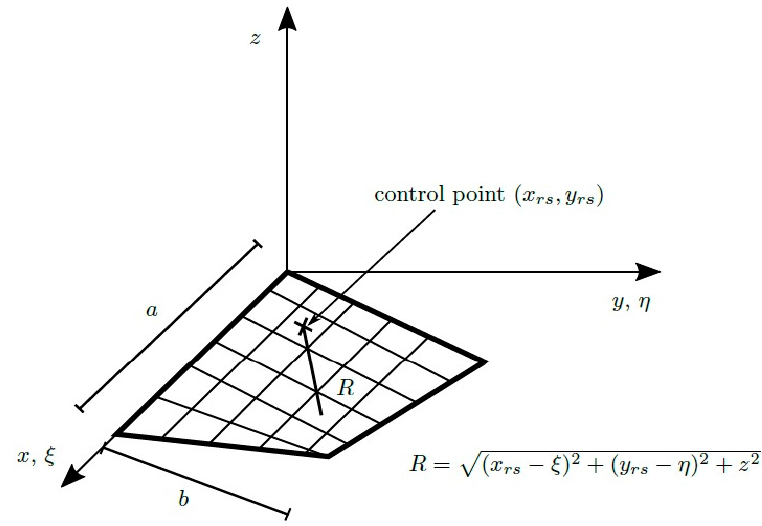
Figure 2. Division of plate into elements.